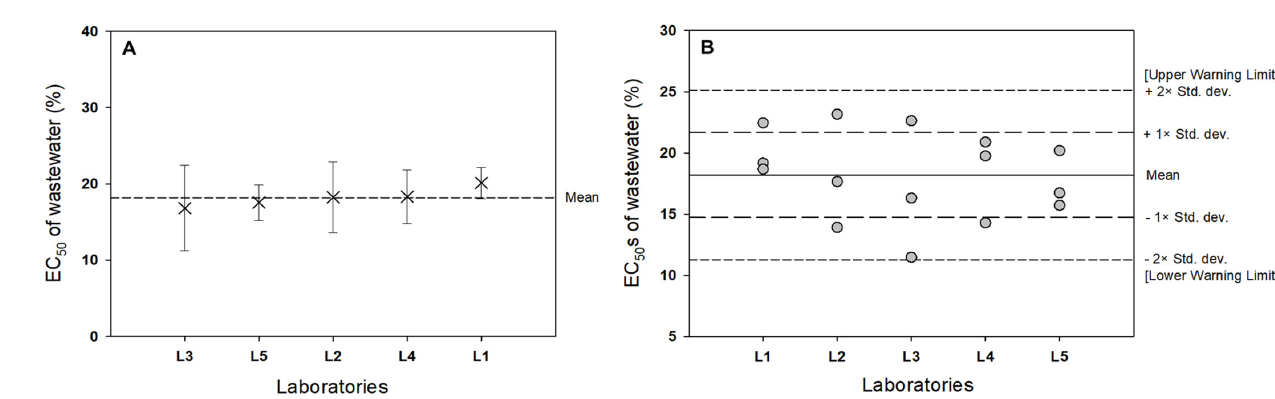
Figure 5. ( A ) Mean EC 50 ± standard deviation from the interlaboratory wastewater toxicity test. (B) Graphical representation of the warning chart approach to the EC 50 of wastewater from 5 laboratories.